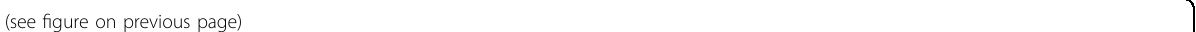
Fig. 6 In fl ammatory changes in the skin and small intestine elicited by EC challenge were attenuated in the antibiotic-treated mice. A Schedule of antibiotic treatments. B Hematoxylin and eosin staining of skin from the antibiotic-treated control (Abx-Con), antibiotic-treated and EC- challenged (Abx-EC), and antibiotic-treated, orally tolerized, and EC-challenged (Abx-OT-EC) mice. The images are representative of two independent experiments. The scale bar represents 200 μ m. C Whole skin thickness (left), epidermal thickness (middle), and dermal thickness (right) of the indicated mice. The graphs show the mean ± SD values. * P < 0.05, ** P < 0.01, **** P < 0.0001 (one-way ANOVA). D mRNA expression of Il1b , Il1rl1 , Il17a , Il25 , Il33 , Il5 , Il13 , Flg , Lor , Mcpt1 , Ccr3 , Prg2 , and Ccl11 in the skin of the indicated mice. All data are representative of two independent experiments. The graphs show the mean ± SD values. * P < 0.05, ** P < 0.01 (Student ’ s t -test for Il1b , I1rl1 , Il5 , Prg2 , and Ccl11 ; Mann – Whi t ney test for Mcpt1 and Ccr3 ). E mRNA expression of Il1b , Il6 , Tnf , Il17a , Il25 , Il33 , Il13 , Cldn4 , Mcpt1 , Ccr3 , Prg2 , Ccl11 , a nd Ccl5 in the small intestine of the indicated mice. All data are representative of two independent experiments. The graphs show the mean ± SD values. * P < 0.05, *** P < 0.001 (Student ’ s t -test for Tnf , Ccr3 , and Ccl5 ; Mann – Whitney test for Il1b , Il17a , and Mcpt1